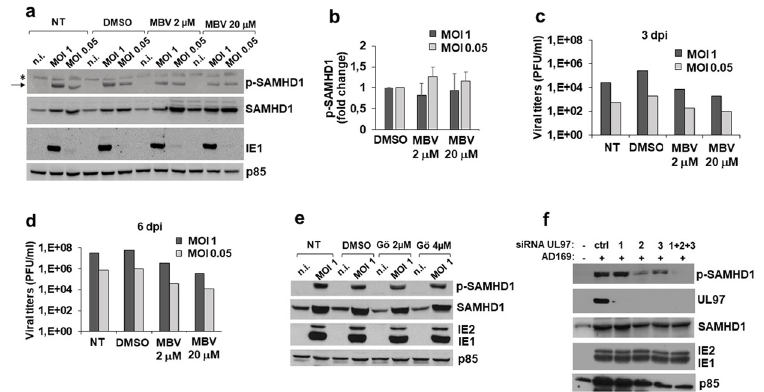
Fig 5. Effects of HCMV kinase pUL97 inhibition on SAMHD1 phosphorylation at T592. a) HFFs were not infected (n.i.) or infected with AD169 at the indicated MOI, in the presence of different concentrations of the pUL97 inhibitor Maribavir (MBV). After removing virus inoculum, MBV was newly added and kept until cell harvesting at 1 dpi. Total or pT592-SAMHD1 levels, expression of IE1/IE2 viral antigens and of p85 were analyzed by immunoblotting as above. A representative experiment out of two performed at 8 hpi, 1, 3 and 6 dpi is shown. b) The relative amount of pT592-SAMHD1 normalized to that of p85 was determined by densitometric analysis and is relative to that of DMSO- treated cells, which was arbitrarily set as 1. Data are expressed as mean ± SE of two independent experiments (MOI 1, 1 dpi). The analysis revealed no statistically significant difference. c-d) Effect of MBV on infectious virus production as measured by standard plaque assays on cell culture supernatants at 3 dpi (c) or 6 dpi) (d). Results derive from one representative experiment out of two. e) Total or pT592-SAMHD1 was analyzed as in panel a) in cells treated with the inhibitor Go¨6976 (Go¨). A representative experiment out of two performed at 3 dpi is shown. f) HFFs were transfected with three different UL97 siRNAs, alone (1, 2, 3) or in combination (1+2+3), or with a non-targeting siRNA (ctrl). The day after, cells were infected with AD169 at an MOI of 1 and harvested at 3 dpi. Immunoblotting was performed as above. One representative experiment out of two is shown. NT, not treated cells; DMSO, cells treated with the vehicle DMSO; � , unspecific band; black arrow, pT592-SAMHD1 specific band.